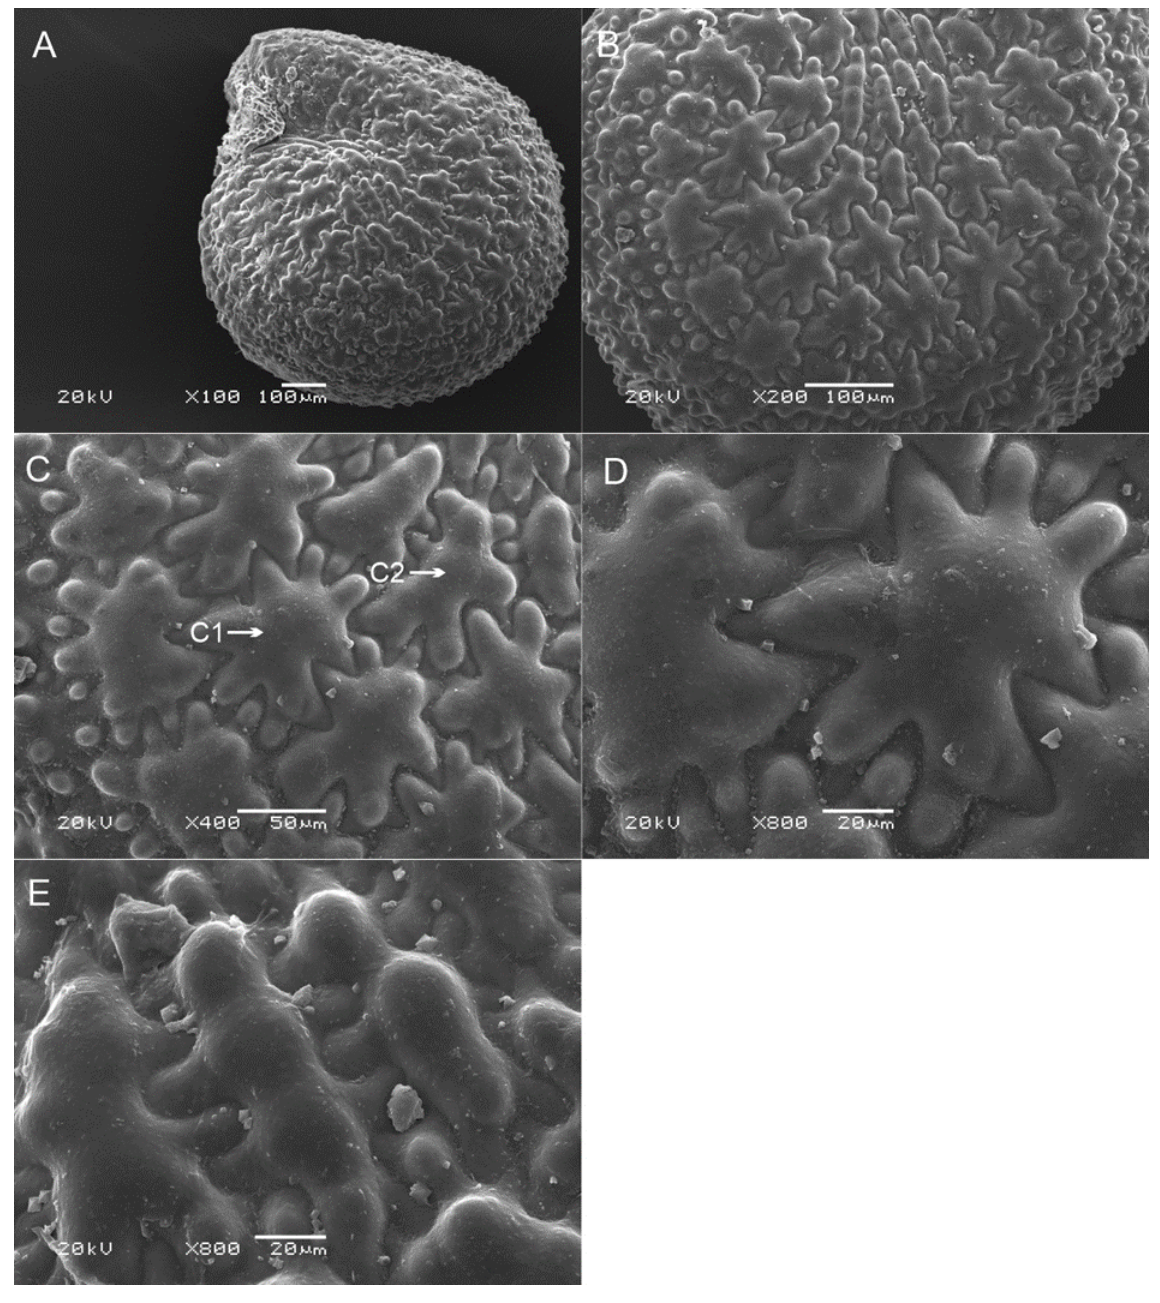
Figure 7 Portulaca papillatostellulata (SEM). General view of the seed ( A ). e seed surface ( B,C ). Isodiametric cell ( C1 ), elongated cell ( C2 ); general view of the cells ( D,E